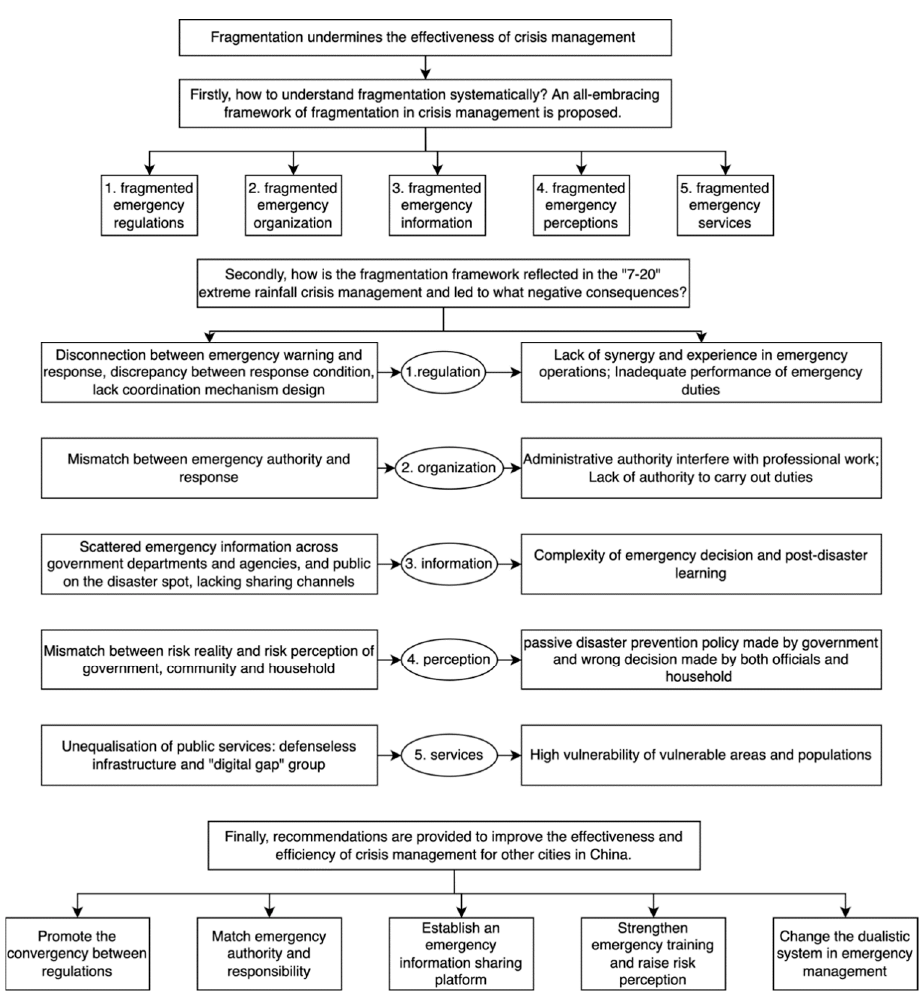
Figure 1. The logical framework of this paper.